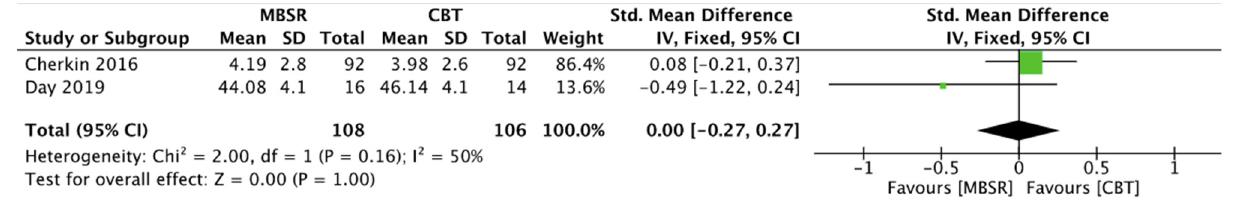
Figure 12. Depression: MBSR versus CBT.